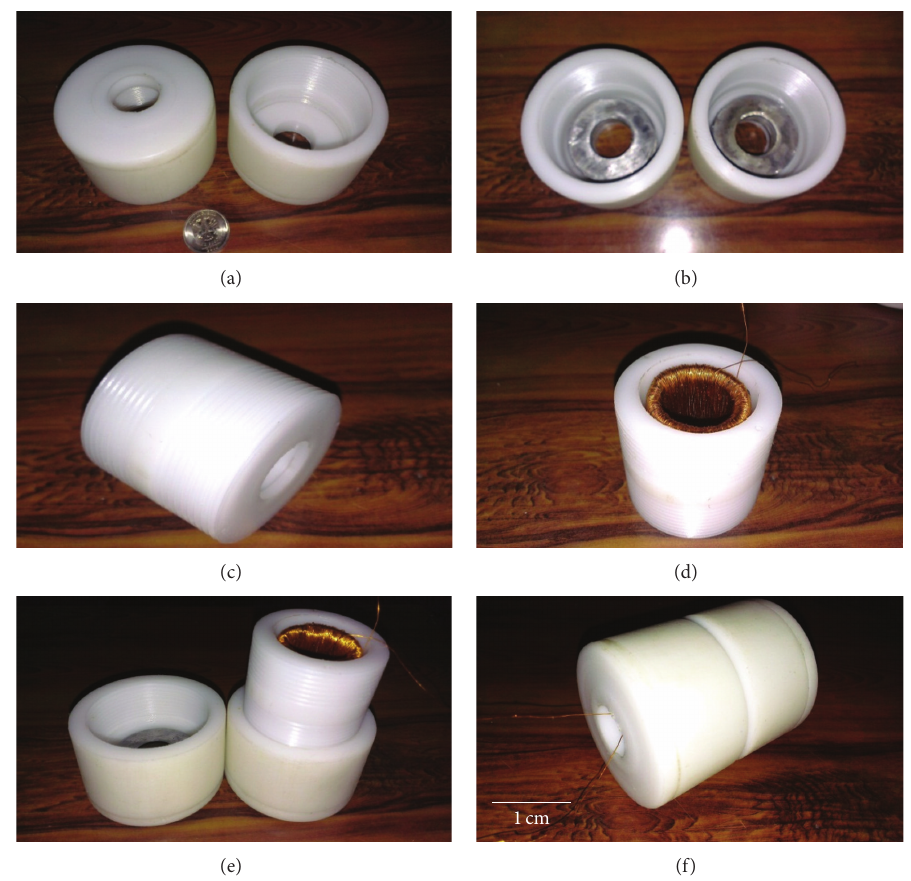
Figure 11: Fabrication of prototype-2: (a) Teflon capacitive energy harvester’s holder caps, (b) capacitive energy harvesters placed in screwed holder caps, (c) screwed Teflon housing for inductive energy harvester, (d) inductive energy harvester placed in the main housing, (e) capacitive energy harvester holder cap screwed on the main housing, and (f) assembled